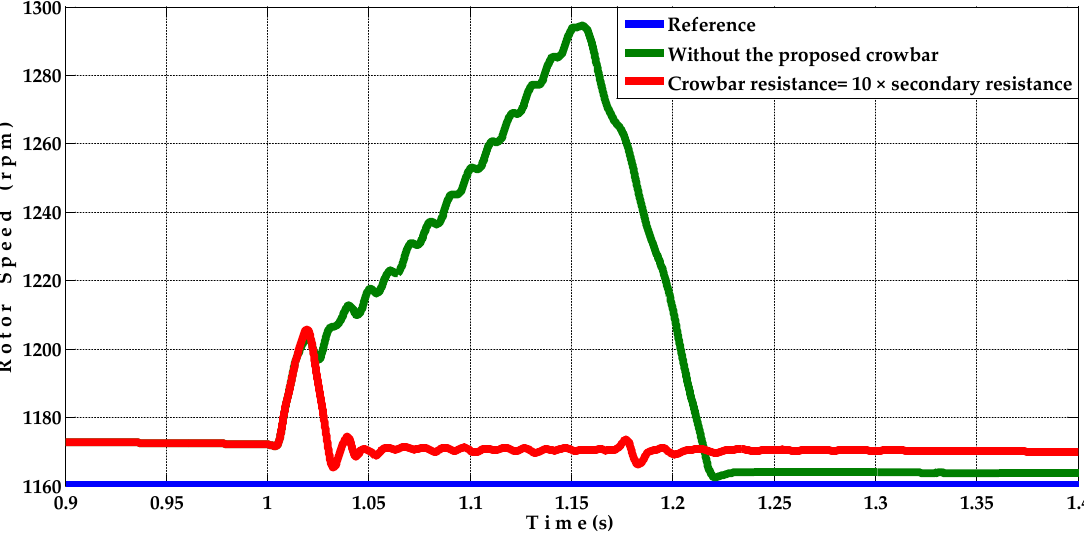
Figure 32. Rotor speed of BDFRG with and without the proposed crowbar under double line to ground fault occurrence.